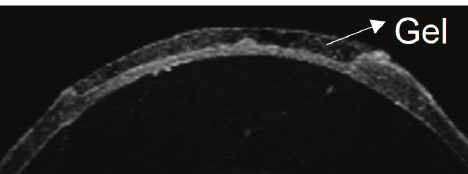
Figure 5. OCT image of a rat corneal defect filled in with a novel in situ forming therapeutic